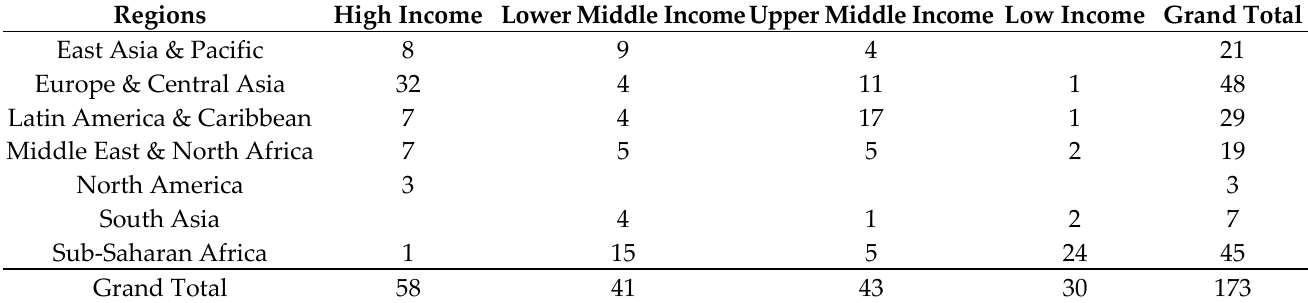
Table 1. Country Distribution